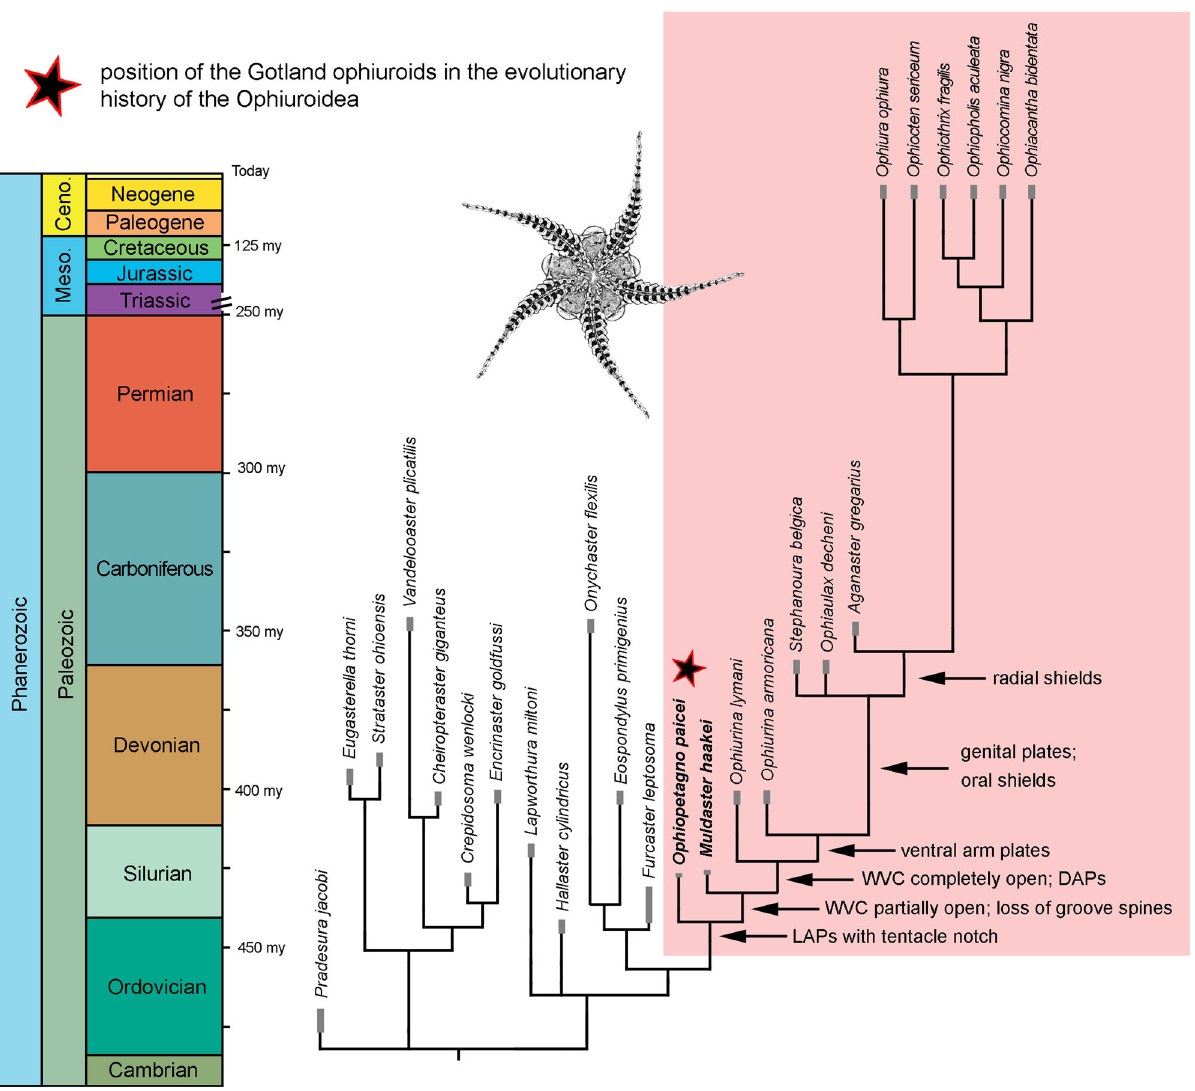
Fig. 2 Evolutionary tree of the Ophiuroidea to show the position of Ophiopetagno paicei and Muldaster haakei from the Silurian of Gotland, Sweden. Arrows indicate synapomorphies at the respective nodes. DAP dorsal arm plate, LAP lateral arm plate, VWC water vessel canal, Ceno. Cenozoic, Meso. Mesozoic. Gray lines indicate documented fossil range of